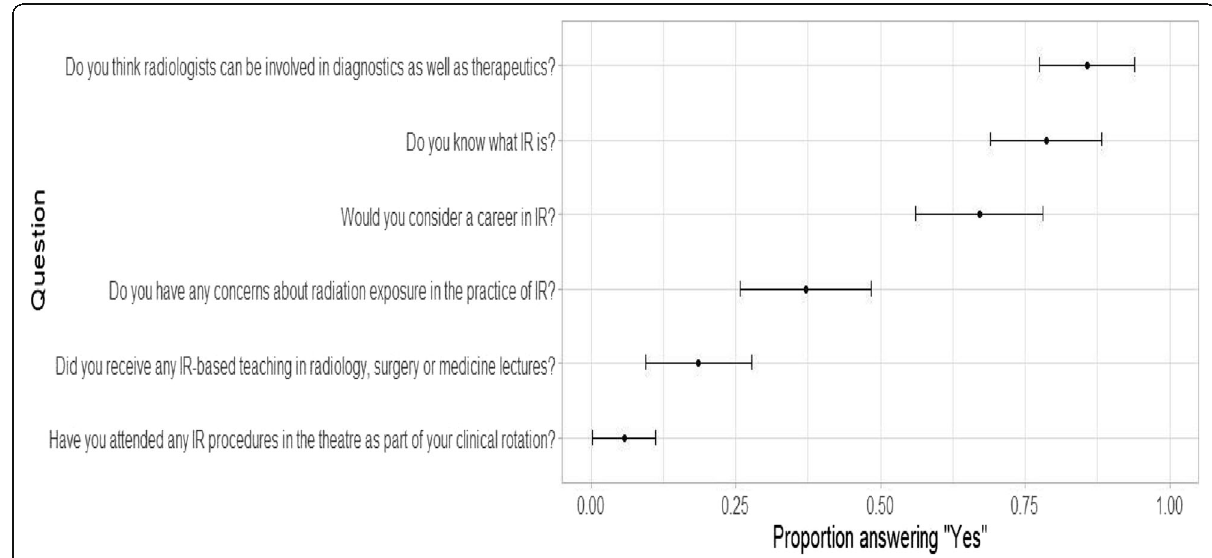
Fig. 2 N = 70. An analysis of survey questions (y-axis) and responses (x-axis) depicted on a 95% CI. Responses to the survey questions indicate that about 70% of students know what IR is and would consider a career in the sub-specialty. Howbeit less than 25% students received an IR theory/ practical